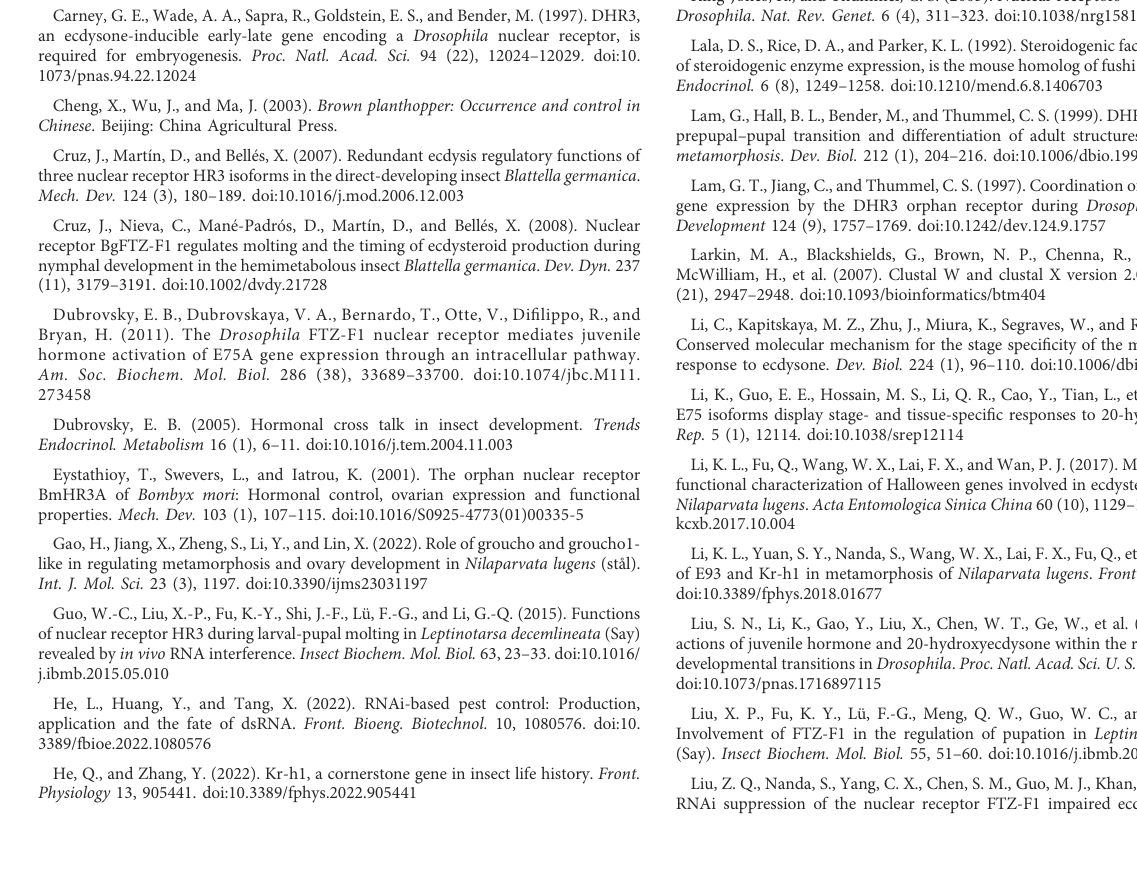
SUPPLEMENTARY FIGURE S1 Splice variant structure comparison. Sequence alignment and phylogenetic tree of HR3. (A) Prediction of conservative domains and comparison of differenttranscriptstructuresof NlHR3 . (B) HR3 sfrom NlHR3A and NlHR3B